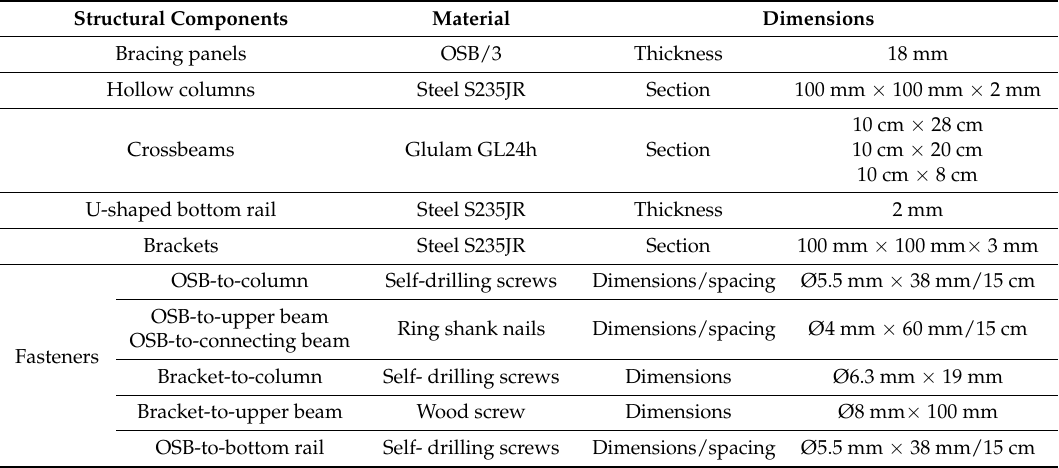
Table 2. Dimensions, fasteners and geometrical details of the